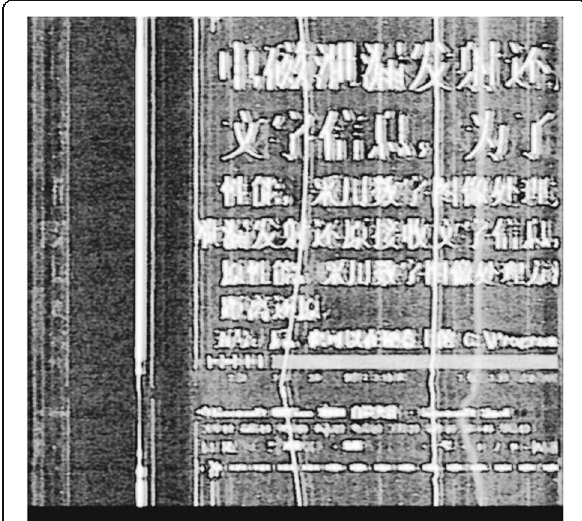
Fig. 9 Weighted mean filtering → blur sharpening → gray balance